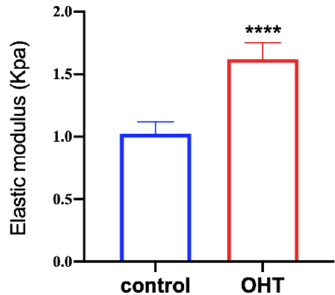
Figure 5. The stiffness of the cells was tested by AFM. The Hertz equation was applied to fit the curve to obtain the elastic modulus. Elastic moduli of TM cells in the OHT group were greater than in the control group (**** p < 0.0001, n = 30).